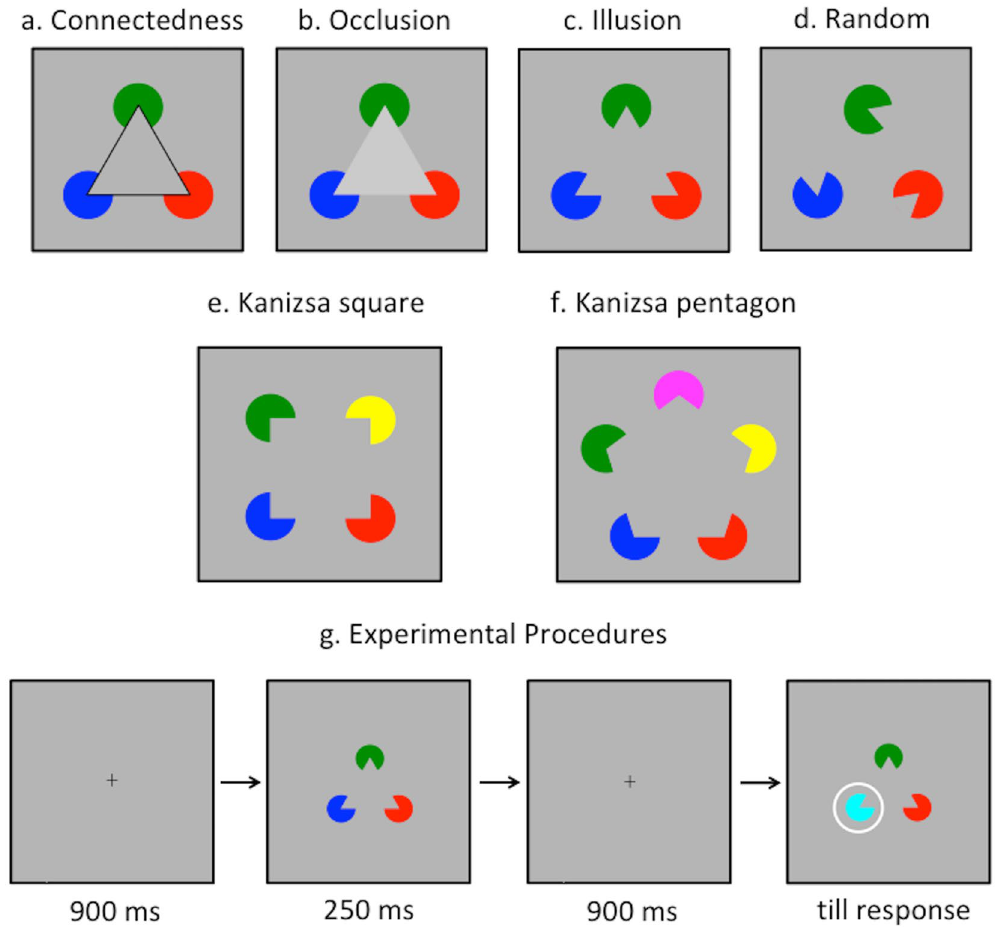
Figure 1. Stimuli and Procedures in Experiment 1. The upper panels show the exemplar stimuli with a set size 3 in the connectedness ( a ), occlusion ( b ), illusion ( c ), and random orientation ( d ) conditions. The middle panels show the exemplar stimuli in the illusion condition with a set size of 4 ( e ) and 5 ( f ). Task sequences are shown in ( g